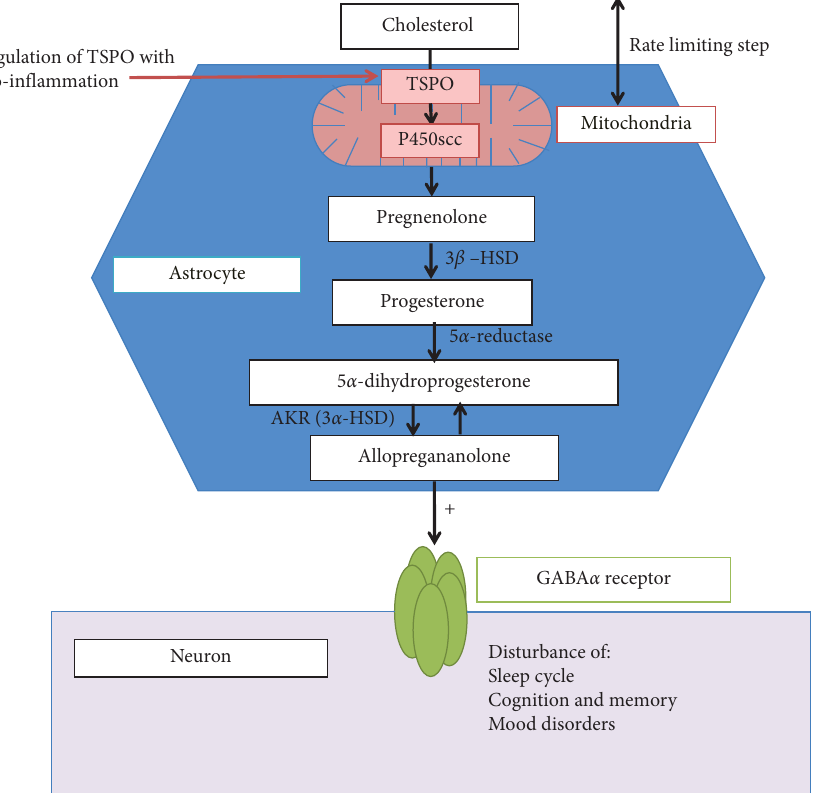
Figure 4: De novo synthesis of allopregnanolone in the CNS. Cholesterol is transported across the mitochondrial membrane by the nucleoside transporter, translocator protein (TSPO) [60], and converted to pregnenolone within the mitochondria of glial cells, such as astrocytes, by side chain cleavage of cytochrome P450 (P450scc). Pregnenolone is subsequently converted to progesterone by 3 β - hydroxysteroid dehydrogenases (3 β -HSD). 5 α -reductase type 1, converts Progesterone to 5 α -dihydroprogesterone (5 α -DHP), 5 α -DHP is then converted to Allopregnanolone by the aldo-keto reductases enzyme, 3 α -hydroxysteroid dehydrogenase (3 α -HSD). Allopregnanolone activates GABA-A receptor intracellular sites by lateral difusion in the neuronal membrane, where it acts as a potent allosteric modulator. Allopregnanolone can eventually be reconverted back to 5 α -DHP by 3 α -HSD